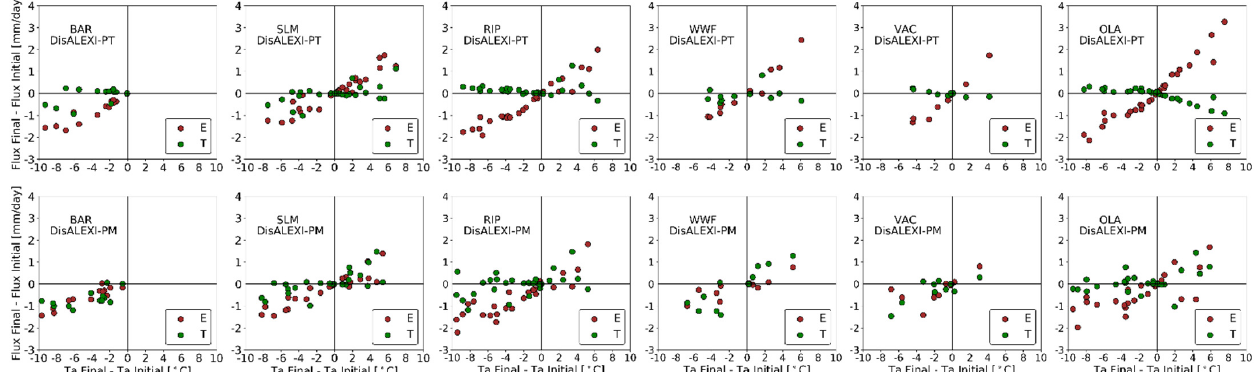
Figure 9. Scatter plot of the difference between final and initial T air (x-axis) and the difference between final and initial E (brown) or T (green) for DisALEXI-PT ( top ) and DisALEXI-PM ( bottom ) approaches on all Landsat overpass dates.